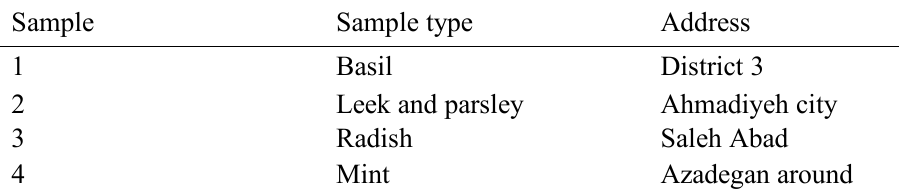
Table 2. Plant sampling